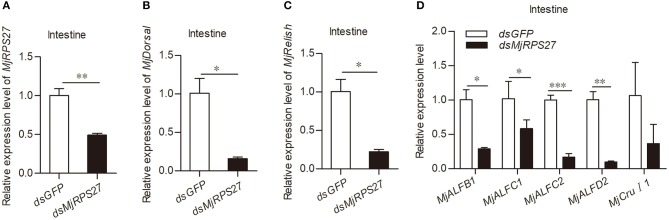
MjRPS27 was involved in the activation of the Toll and IMD pathways. (A) The RNA interference efficiency of MjRPS27 was analyzed by qPCR 48 h after dsMjRPS27 injection. The same amount of dsGFP was injected as a control. (B) After knockdown of MjRPS27, the expression level of MjDorsal was analyzed by qPCR. The mRNA expression level of MjDorsal was significantly downregulated compared with the control (dsGFP injection). (C) After knockdown of MjRPS27, the expression level of MjRelish was analyzed by qPCR. The mRNA expression level of MjRelish was significantly downregulated compared with the control (dsGFP injection). (D) After knockdown of MjRPS27, the expression levels of AMPs (MjALFB1, MjALFC1, MjALFC2, MjALFD2, and MjCruI 1) were analyzed by qPCR. The expression levels of AMPs, except MjCruI 1, were significantly downregulated compared with the control (injected dsGFP). *p < 0.05; **p < 0.01; ***p < 0.001.